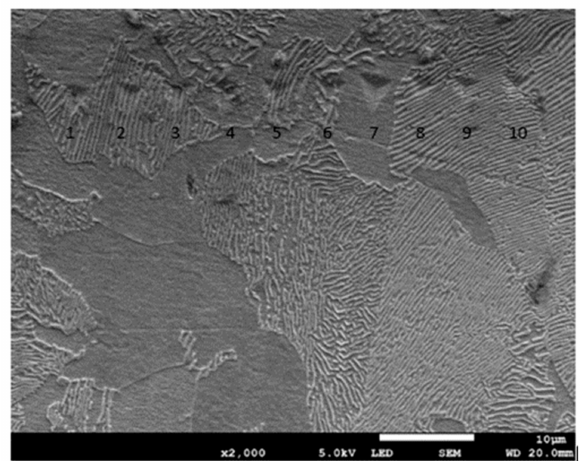
Figure 14. Micrograph showing impressions after the nanoindentation test for C45 steel grinded to a depth of 2 µ